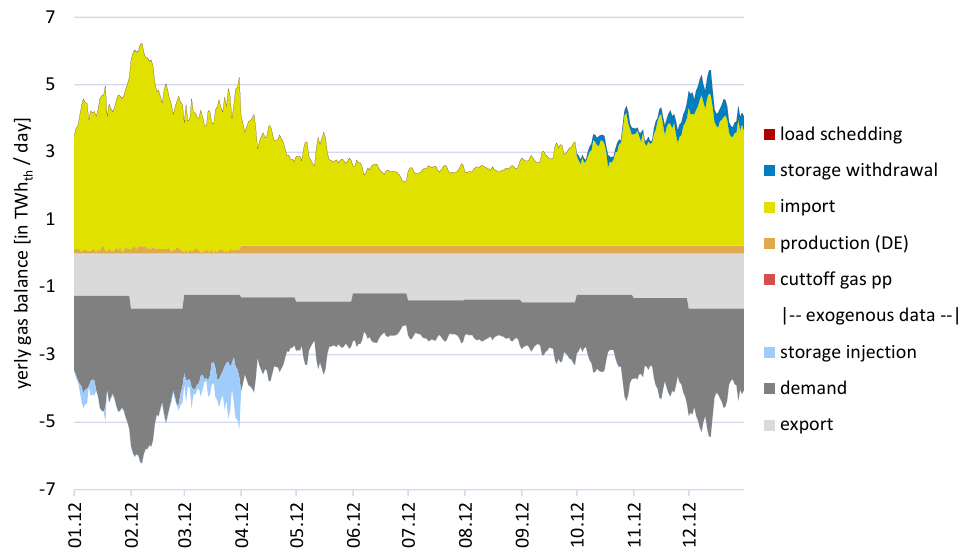
Figure 8. Results of GAMAMOD-DE for yearly natural gas balances in daily resolution in 2012.